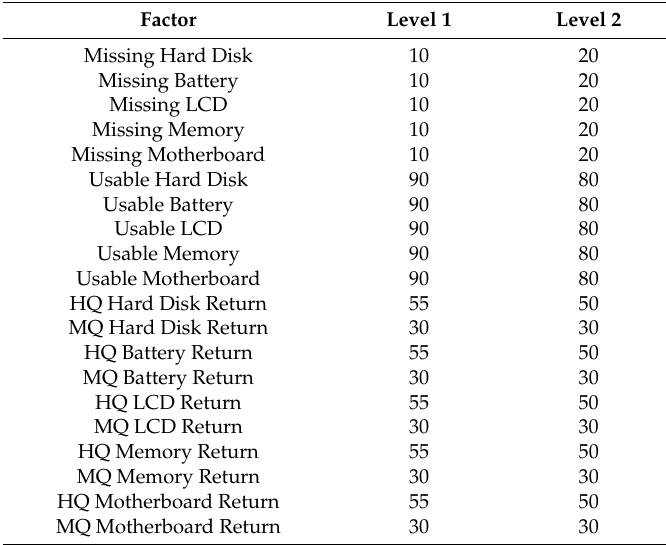
Table 4. Probability factors (%).